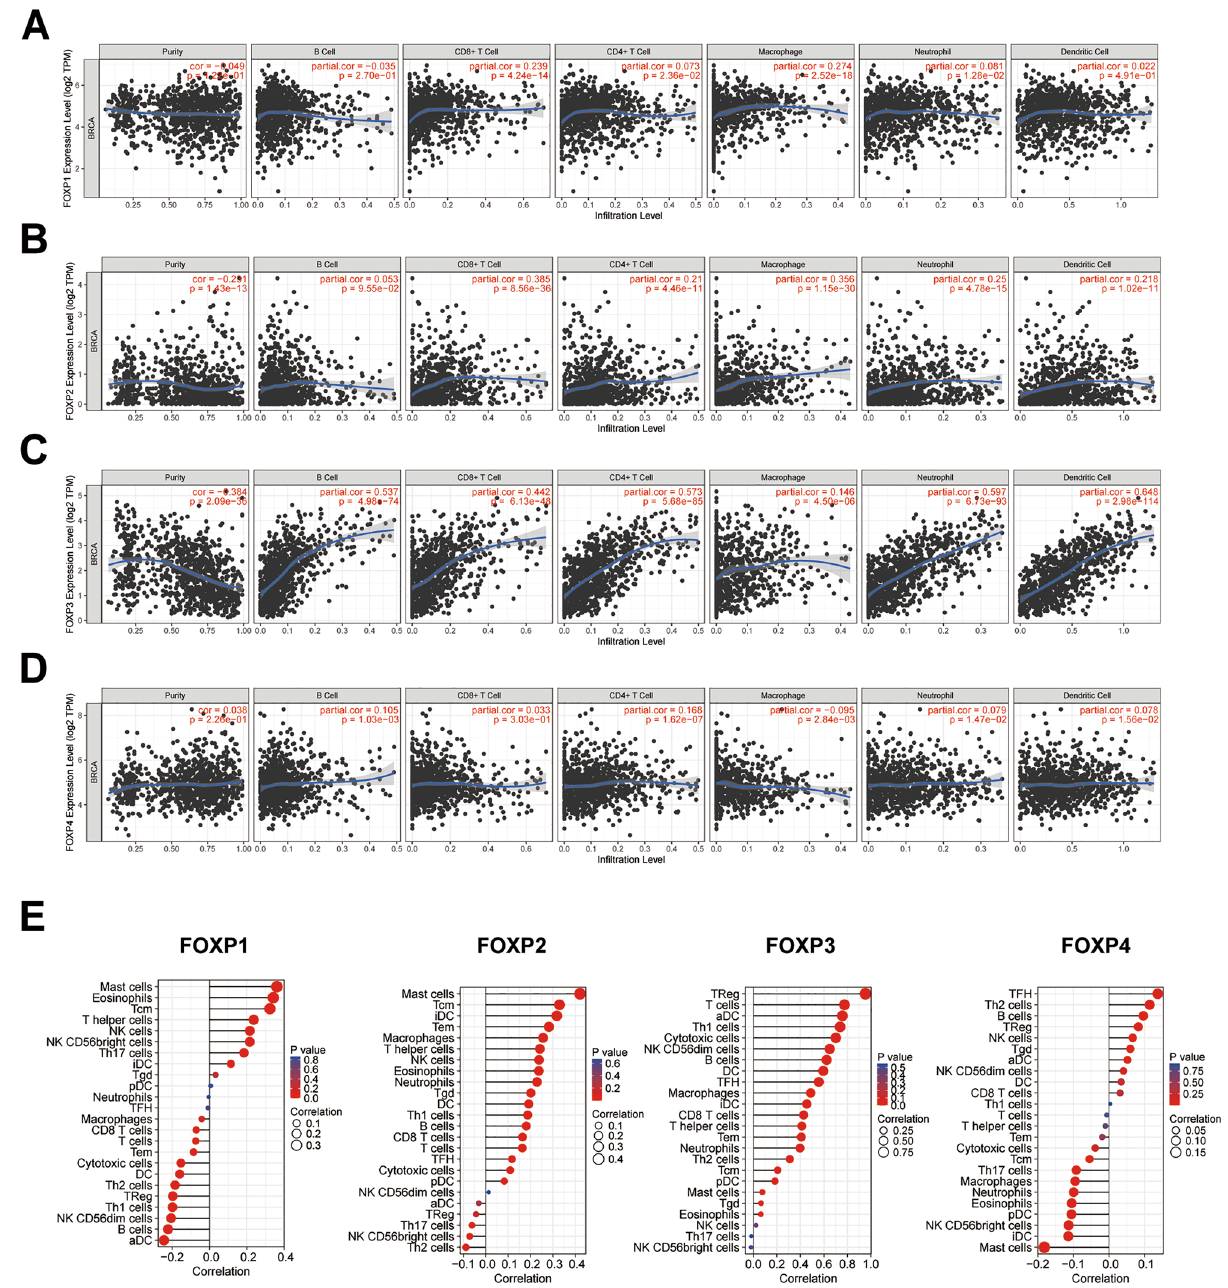
( D ) FOXP4 in BRCA (TIMER). ( E ) Lollipop chart about correlation between 24 immune cell and the expression of FOXPs in